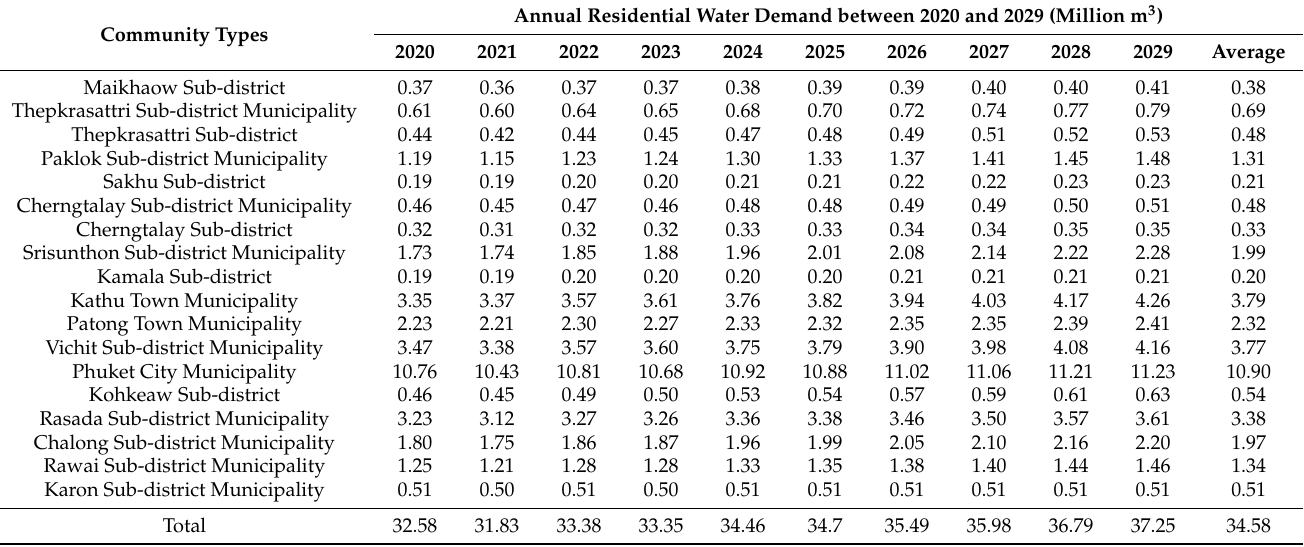
Table 20. Annual residential water demand in different community types between 2020 and 2029. Community